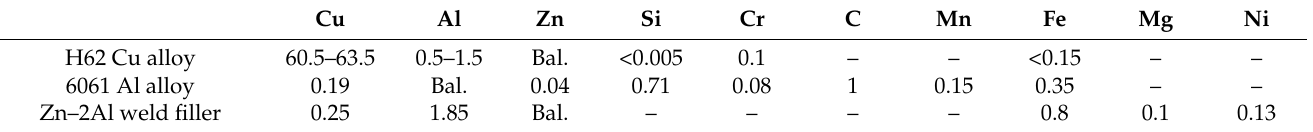
Table 2. Process parameters in this study. Experimental Parameters Value Distance from the focus position to the Cu surface +20 mm Laser power 2400 W Velocity of welding 0.36 m/min Flow rate of the shielding gas, Ar 15 L/min Velocity of wire feeding 4 m/min Thickness of the tin foil 0.3/0.5 mm Thickness of the Ni coating 4.56 µ